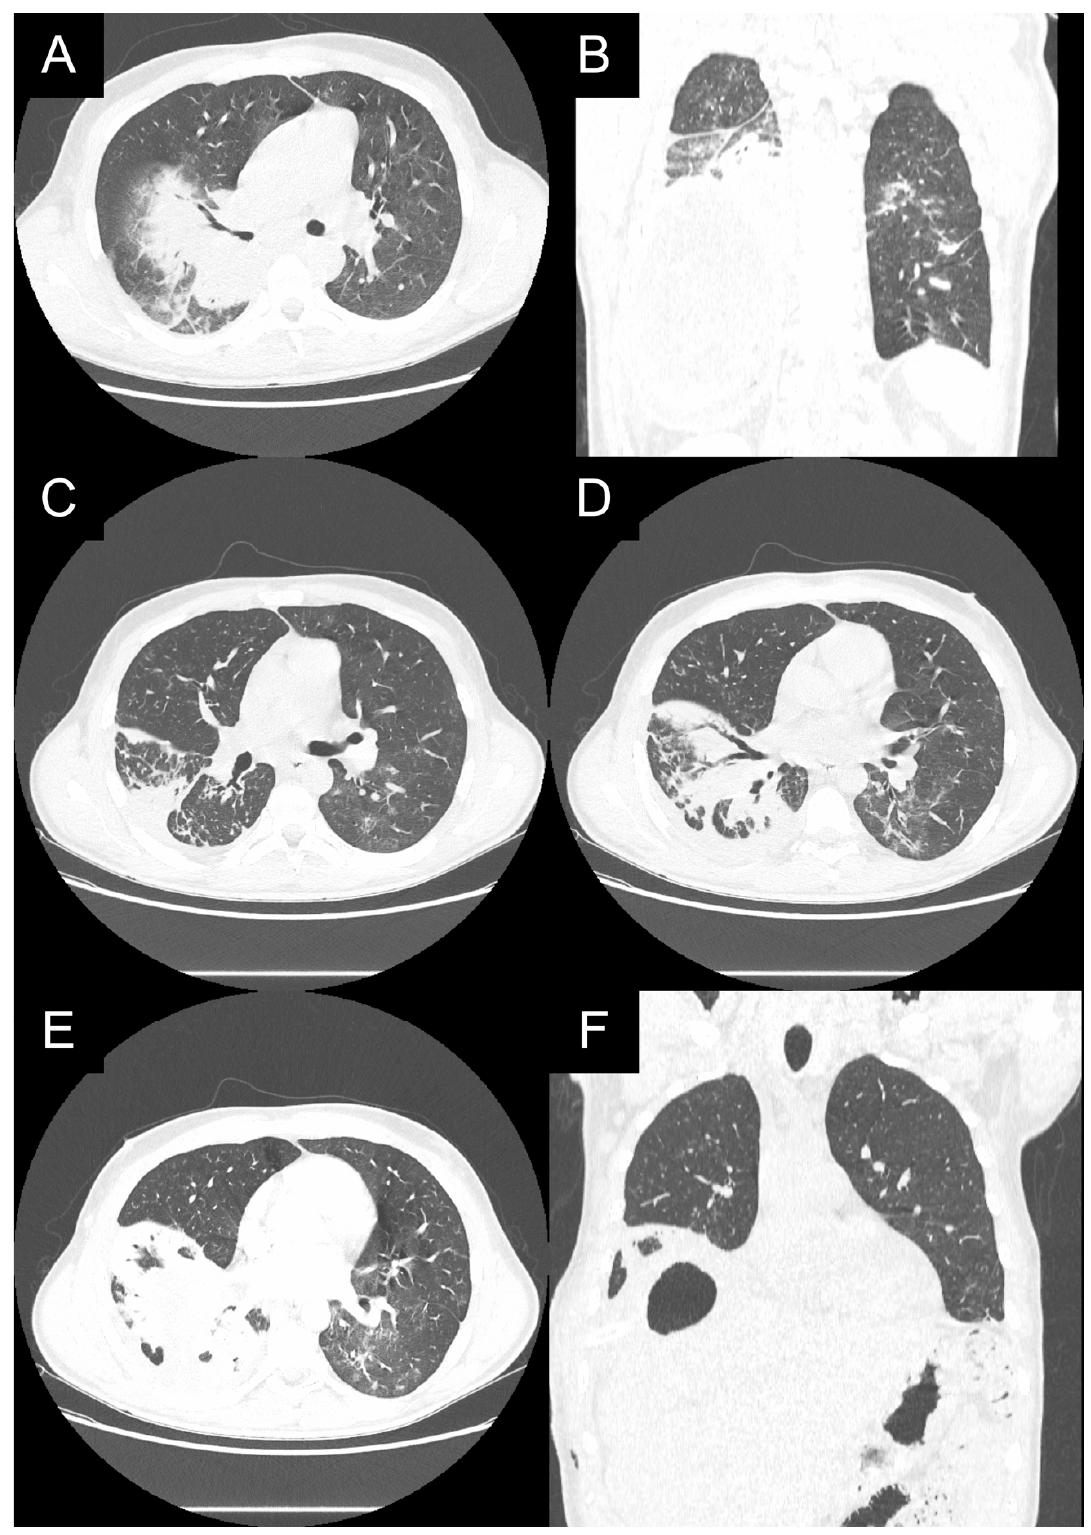
Figure 5. ( A – F ): A chest CT of patient 1 showing ruptured continuity of the hepatic lesion. The right lower lobe bronchi are filled with fluid from hepatic lesion. At bronchoscopy, an S10 fistula was detected.